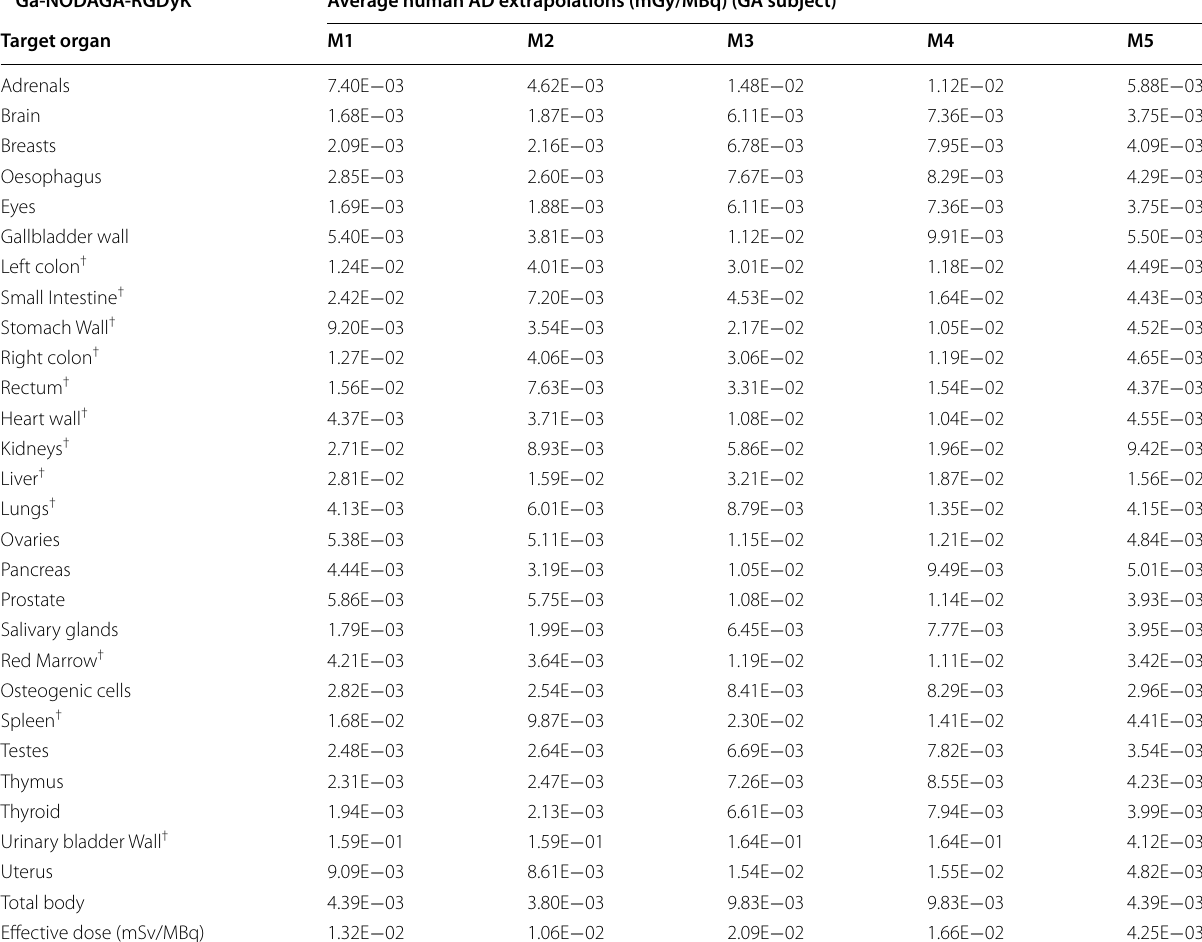
Mouse-to-human dose extrapolations were based on time-integrated activity coefficients (TIACs) obtained from biodistribution data on mice, reported in [25]. Human TIACs were calculated for male and female subjects with five different computational methods and used as input in OLINDA/EXM v.2.1 to derive gender average (GA) organ absorbed doses (ADs) and effective doses (ED) according to the ICRP-103 [32]. † Indicates source